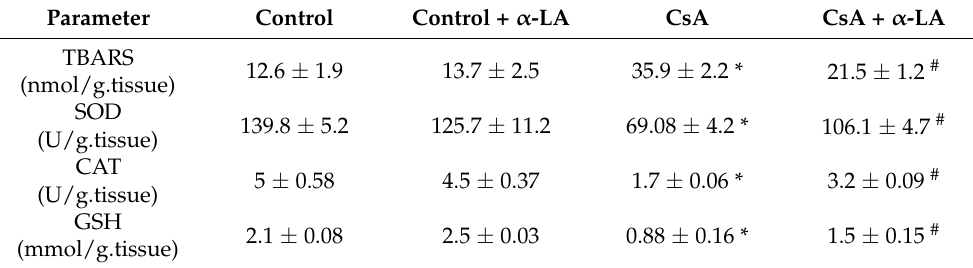
Data are expressed as mean ± SE, * CsA-treated group versus control group at p < 0.05, # α -LA+ CsA-treated group versus CsA-treated group at p <